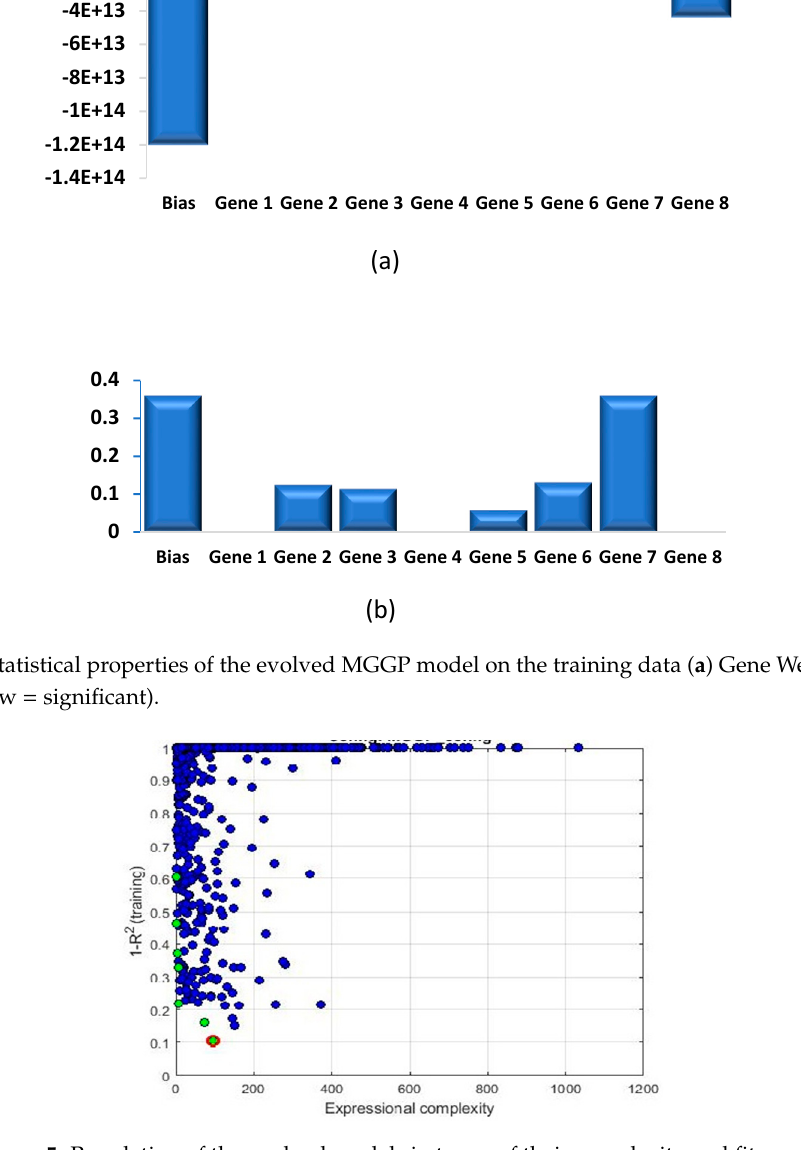
Figure 5. Population of the evolved models in terms of their complexity and fitness.